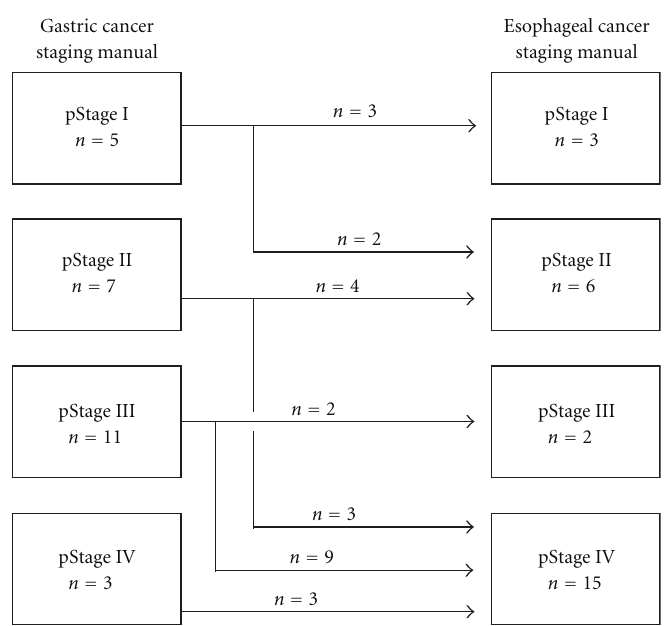
F 1: Staging comparison of gastric cardia cancer with esophageal invasion